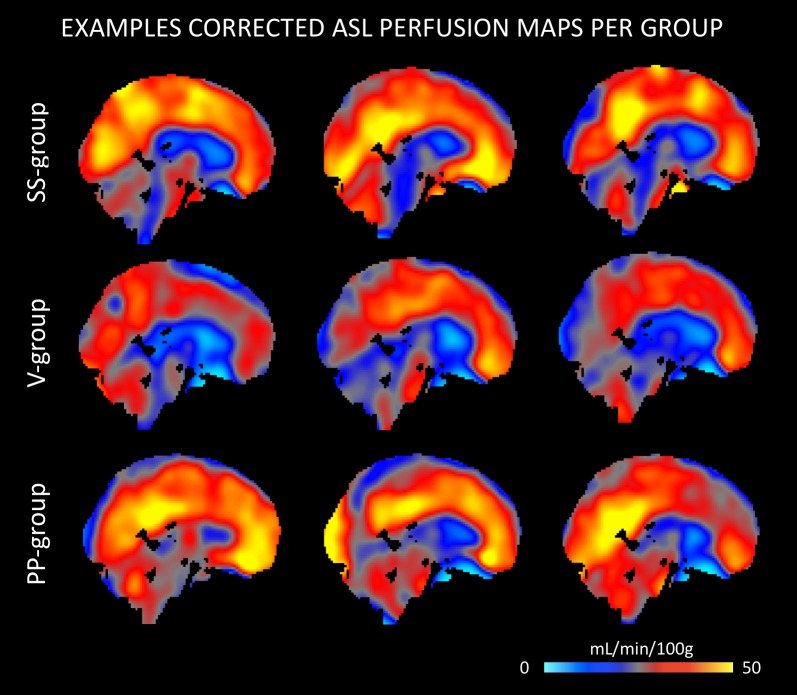
Example ASL perfusion maps of stable-stable (SS), V, and PP group separately. The examples of the V group demonstrate a lower perfusion within the precuneus, while in the example maps of both the SS and PP group perfusion in these regions remains relatively preserved.